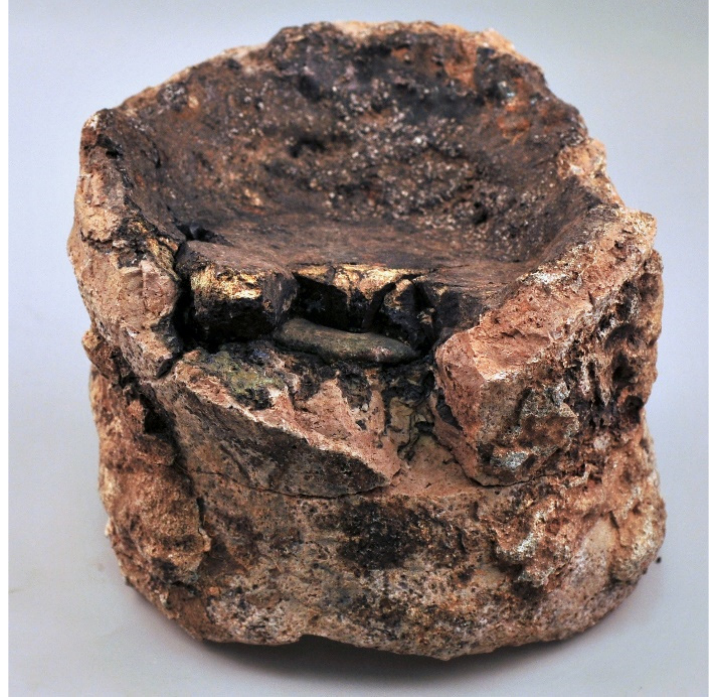
Figure 3. Crucible from Svor with dark blue glass layer.